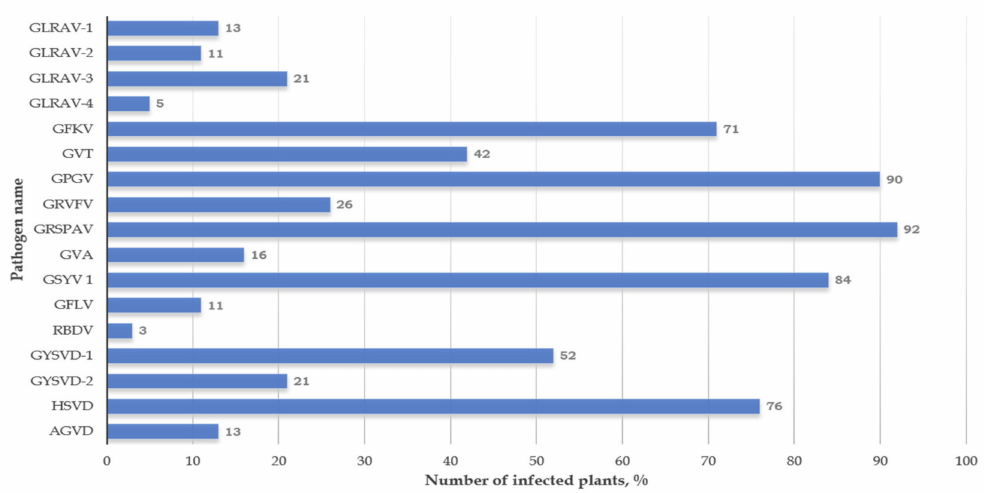
Figure 3. Frequency of occurrence of grapevine viruses (percentage of the total number of collected